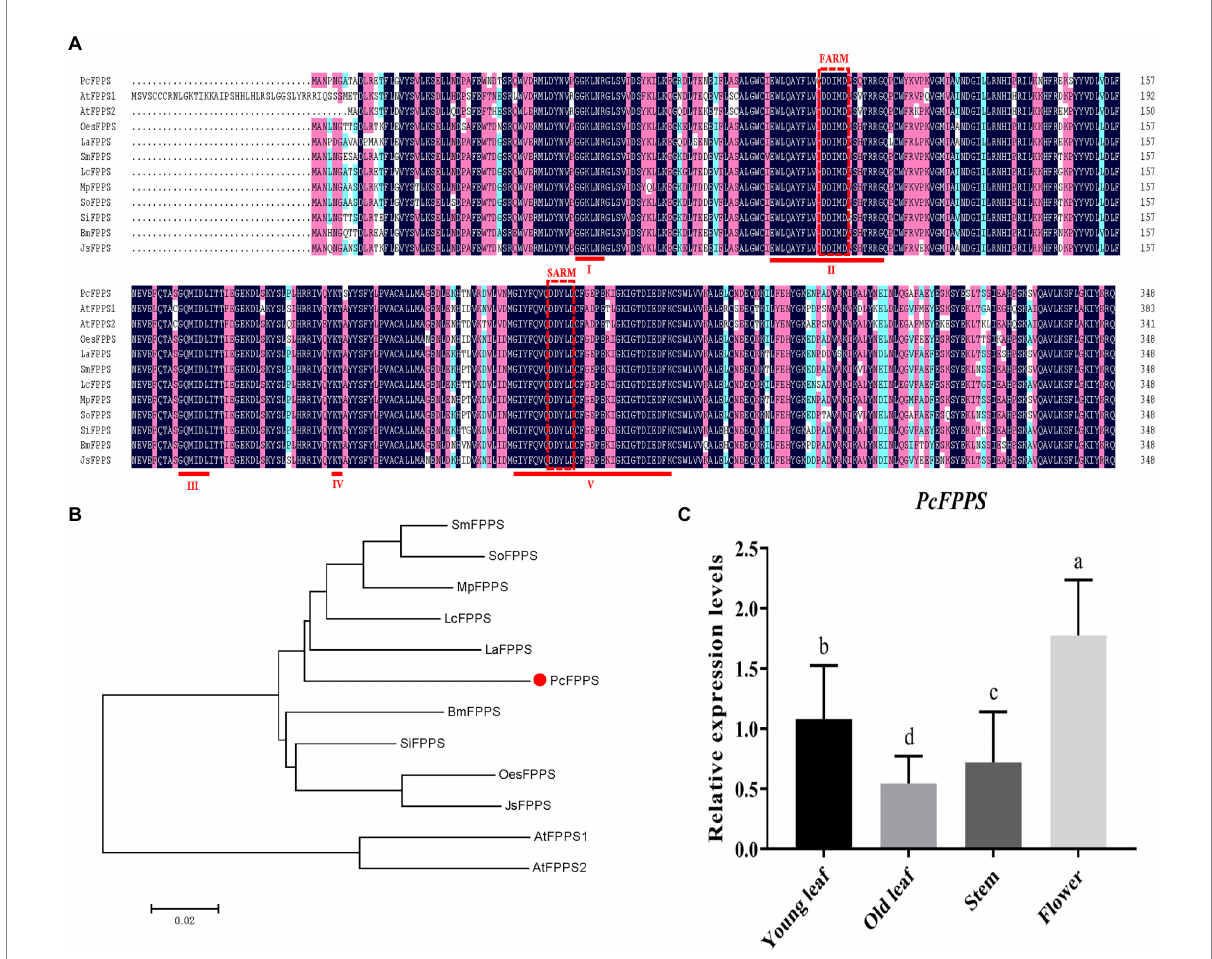
FIGURE 1 Bioinformatics analysis and expression profiles of PcFPPS . (A) Multiple sequence alignment of PcFPPS, Arabidopsis thaliana AtFPPS1 (NP_199588), Arabidopsis thaliana AtFPPS2 (NP_193452.1), Salvia miltiorrhiza SmFPPS (ABV08819.1), Leucosceptrum canum LcFPPS (ALT07952.1), Mentha x piperita MpFPPS (AAK63847.1), Salvia officinalis SoFPPS (AQY54371.1), Sesamum indicum SiFPPS (XP_011095887.1), Bacopa monnieri BmFPPS (ADV03080.1), Lavandula angustifolia LaFPPS (AGQ04160.1), Olea europaea var. sylvestris OesFPPS (XP_022879277.1), and Jasminum sambac JsFPPS (AIY24422.1). Similar, conserved and identical amino acid residues are shown in light blue, light purple, and dark blue. The five conserved regions contained in the FPPS family proteins are marked as I ~ V. Aspartate-rich regions located in conserved regions II and V are shown as red dashed boxes with FARM (First Aspartic Rich Motif) and SARM (Second Aspartic Rich Motif). (B) Phylogenetic tree of PcFPPS and other species FPPS proteins. The analysis was performed using the neighbor-joining method by the MEGA7. PcFPPS is shown as red solid dot. (C) The relative expression levels of PcFPPS in young leaf, old leaf, stem, and flower of P. cablin . Data are indicated as mean ± SD ( n = 3). Statistically significant differences are analyzed using ANOVA combined with Bonferroni’s test ( p < 0.05) and indicated as different